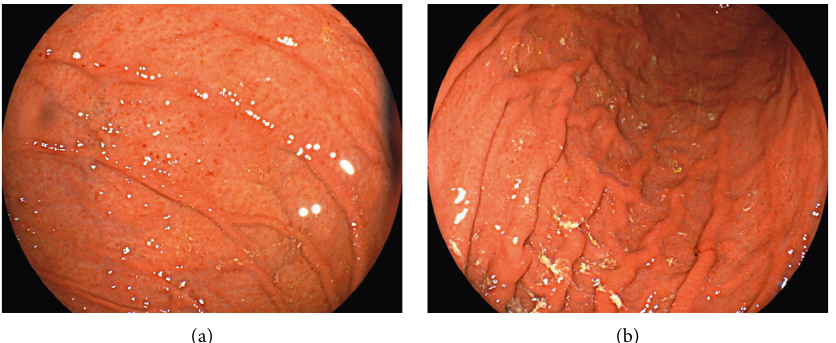
Figure 4: Esophagogastroduodenoscopy images two months after the eradication therapy. Spotty redness still exists at the gastric fornix (a), while mucosal swelling and diffuse redness are not observed in the corpus